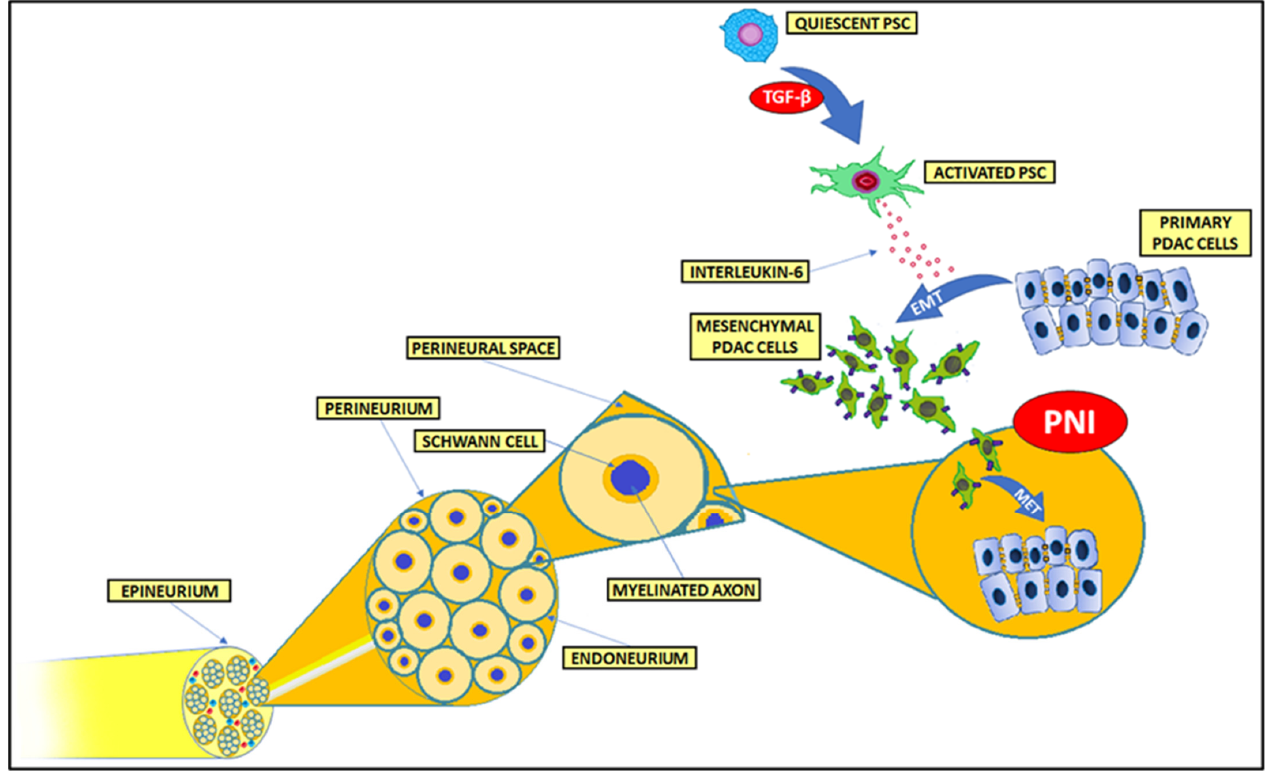
Figure 3. Schematic presentation of the structure of a peripheral nerve. Primary PDAC cells undergo EMT and in a mesenchymal state invade the perineural space of autonomic nerves, where MET-like changes in PDAC cells promote tumor colonization within the nerve. PDAC, pancreatic ductal adenocarcinoma; EMT, epithelial–mesenchymal transition; MET, mesenchymal–epithelial transition; PNI, perineural invasion; PSC, pancreatic stellate cell.